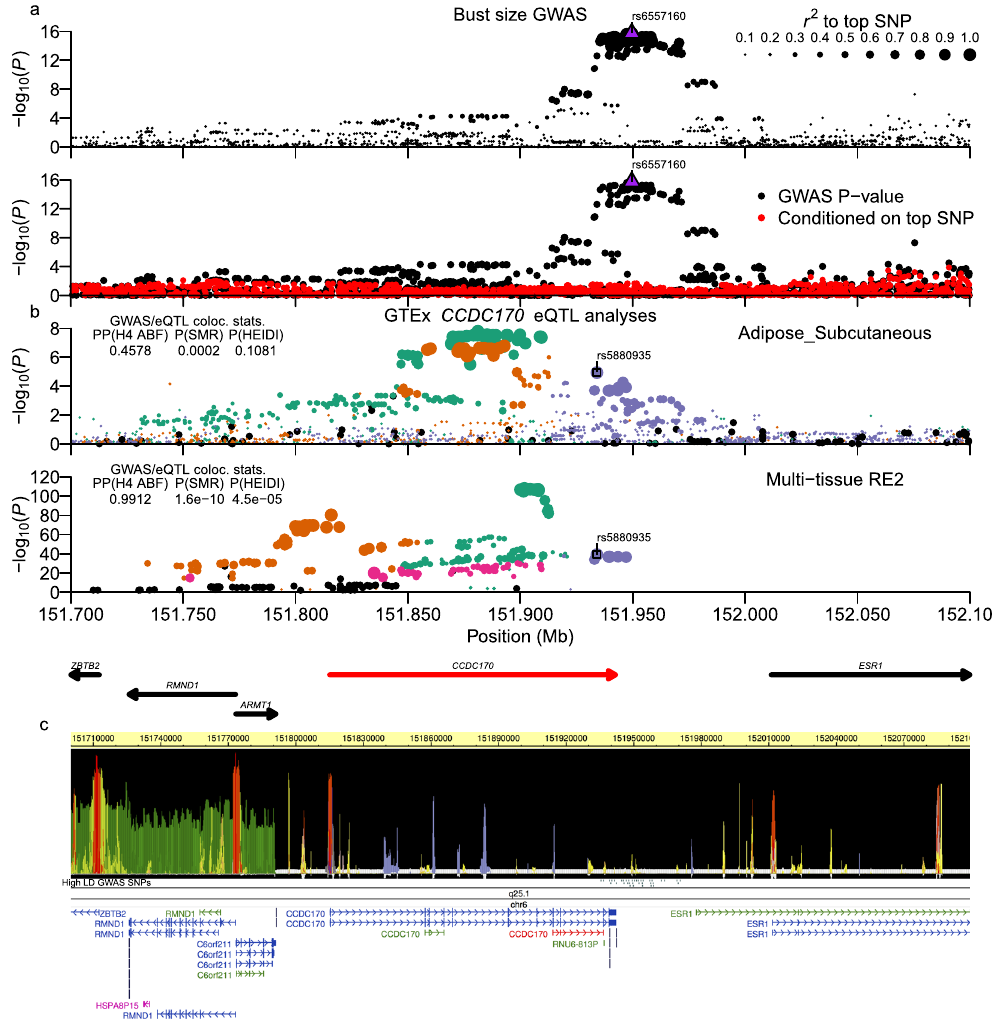
Figure 1. Bust-size chr6:151.92–151.99 Mb ( CCDC170 ) locus. ( a ) Plot of − log 10 (P-values) around association signal. Upper sub-panel displays points sized by LD r 2 to the top SNP. Lower panel shows -log 10 (P-values) with (red circles) and without (black circles) conditioning on the top SNP. The top SNP in each panel is plotted as a purple upright triangle. ( b ) Analysis of GTExPortal CCDC170 eQTL data. Sub-panels plot either single-tissue or multi-tissue Metasoft RE2 eQTL association statistics, with the tissue or multi-tissue status labelled at the upper-right corner. Each single- or multi-tissue eQTL analysis was processed to identify putative independent signals based on pairwise EUR or AFR LD r 2 . SNPs in each sub-panel are colored by signal assignment and rank of the top SNPs (1 st ranked = green, 2 nd = orange, 3 rd = purple, 4 th = magenta) and sized by LD r 2 to each signal’s top SNP. Inset left-side table shows GWAS/eQTL colocalization statistics: the posterior probability (PP) from the coloc Approximate Bayes Factor test (H4 ABF) and P-values for the Summary data-based Mendelian Randomization (SMR) and heterogeneity-in-dependent-instruments (HEIDI) tests. PP H4 ABF > 0.3 and PP H4 > 0.5 were considered as nominal and moderate support of colocalization, and PP > 0.9 as strong ABF H4 ABF support of colocalization/pleiotropy. We considered P SMR < 0.05 as supporting linkage/colocalization and with P HEIDI ≥ 0.05 as strong support of pleiotropy. Main figures show representative single-tissue or multi-tissue data that had strong support for colocalization/pleiotropy ( PP H4 ABF > 0.9 | ( P SMR < 0.05 & P HEIDI ≥ 0.05)). The top eQTL SNP in a colocalized signal is plotted as an open square. The ABF colocalization method for the current analysis was run using β -coefficients and standard errors. Coordinates and strand of genes from GENCODE V27 (bld. 37 liftover) are plotted below the mult-tissue sub-panel. The target eQTL gene is highlighted in red. ( c ) shows RoadMap Epigenomics epilogos plot for the 25-state imputed epigenetics segments, high LD GWAS variants ( r 2 equiv > 0.8), chrom. Band, and gene transcript